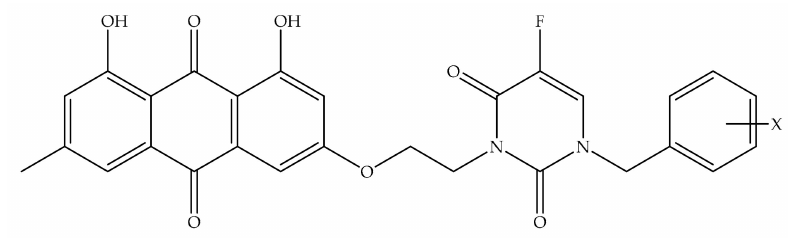
Figure 12. Chemical structure of emodin linked with 5-fluorouracil